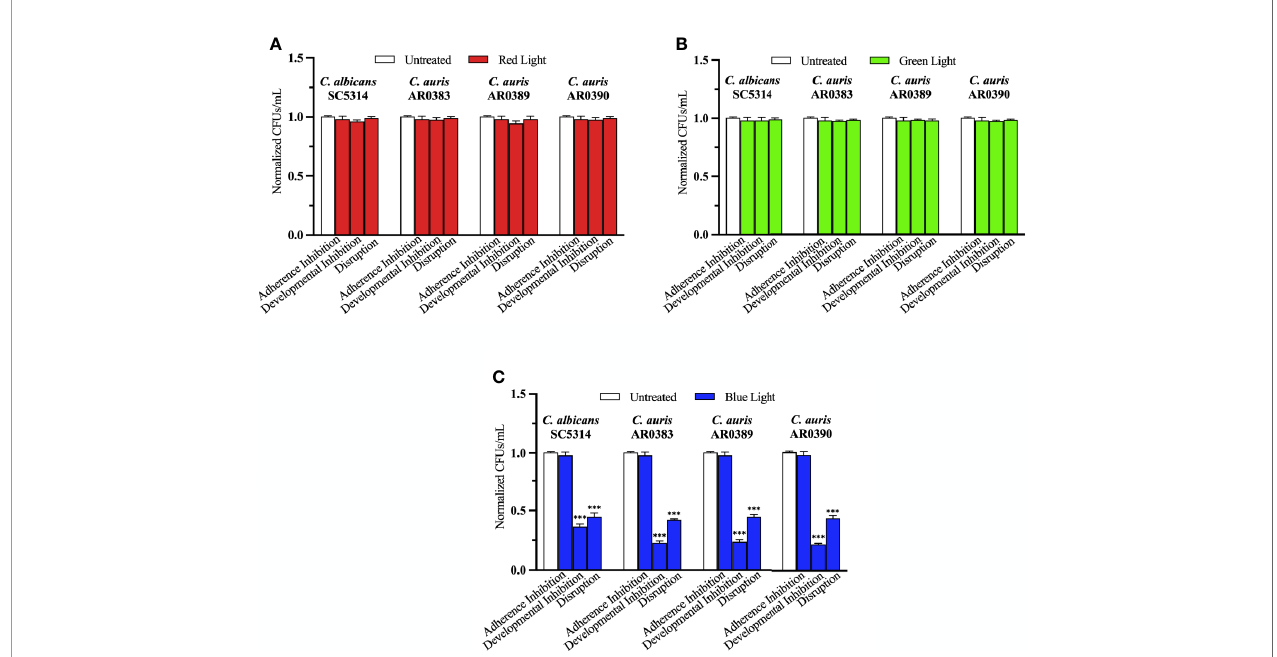
FIGURE 2 | Blue visible light alone is effective against C . auris bio fi lms. C . albicans (SC5314) and C . auris (AR0383, AR0389, and AR0390) bio fi lms were exposed to red, green, and blue visible lights individually in the adherence inhibition, developmental inhibition, and disruption bio fi lm assays. CFUs/mL were counted to determine viable cell counts at the end of each of the bio fi lm assays. Effects of (A) red light alone (Red Light), (B) green light alone (Green Light), and (C) blue light alone (Blue Light) in the three different bio fi lm assays compared to an untreated control (Untreated). Standard deviations are shown for each sample (n = 3). The average CFUs/ mL of the untreated control samples for each assay were normalized to 1. Signi fi cance comparisons are relative to the untreated control and were determined using student ’ s unpaired two-tailed t-tests assuming unequal variance for p ≤ 0.001